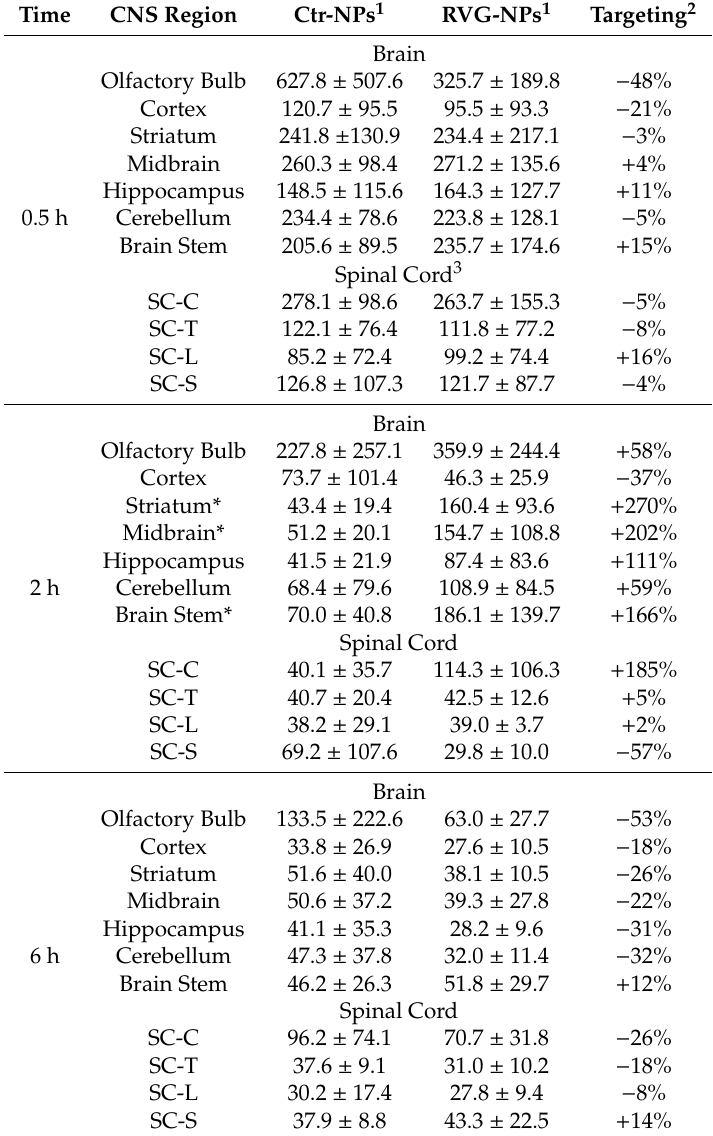
Table 2. Concentration of DiR (ng / g tissue) measured within specific CNS regions of the central nervous system (CNS) following intranasal administration of